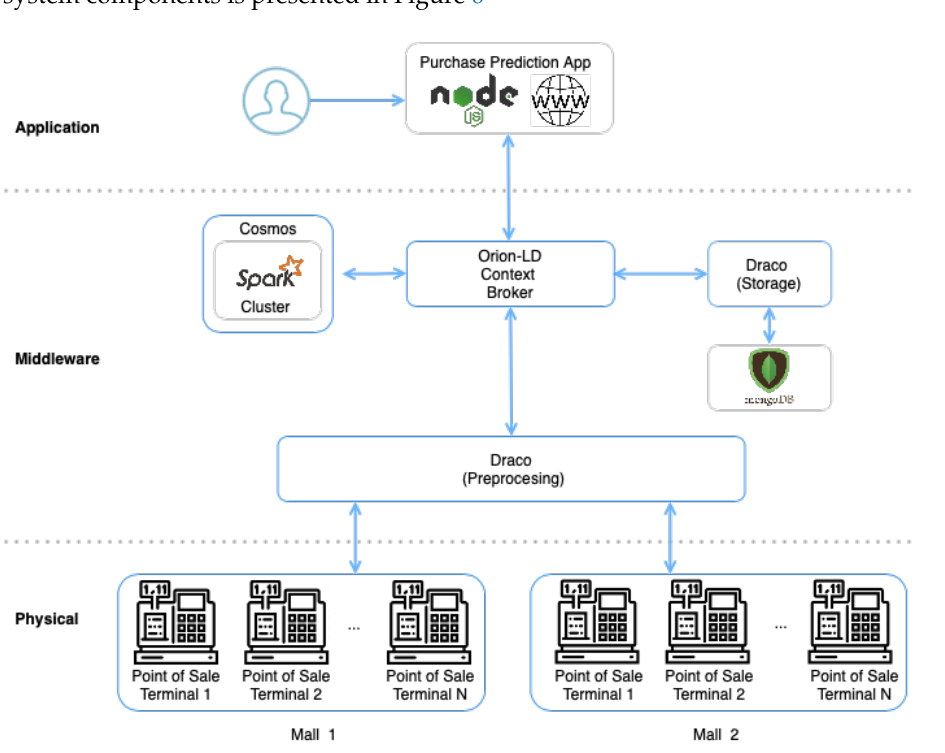
Figure 6. Graphical overview of the Supermarket